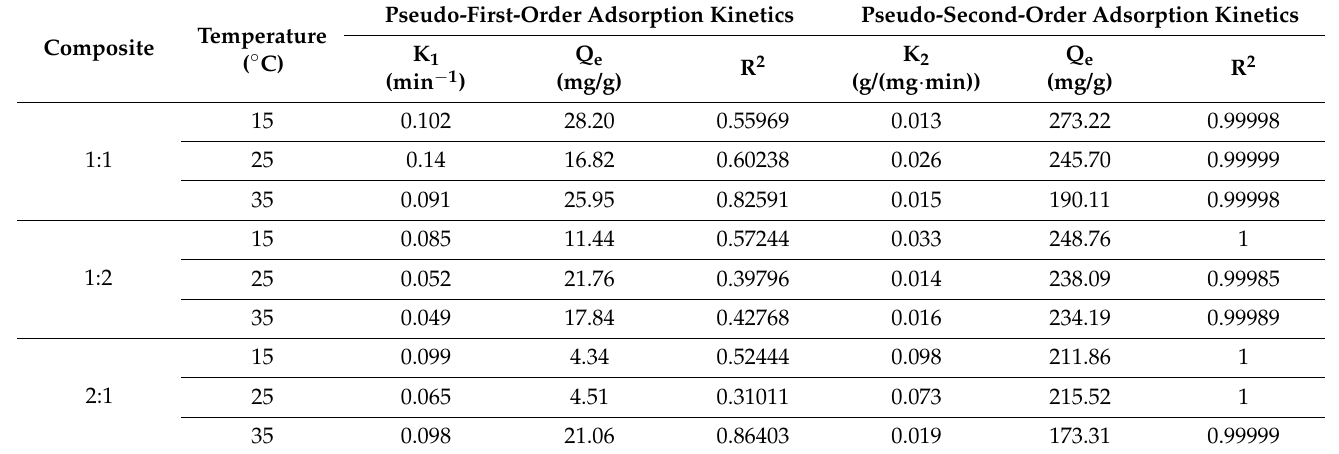
Table 3. Kinetic fitting parameters of PNMBC for Cu(II) adsorption.